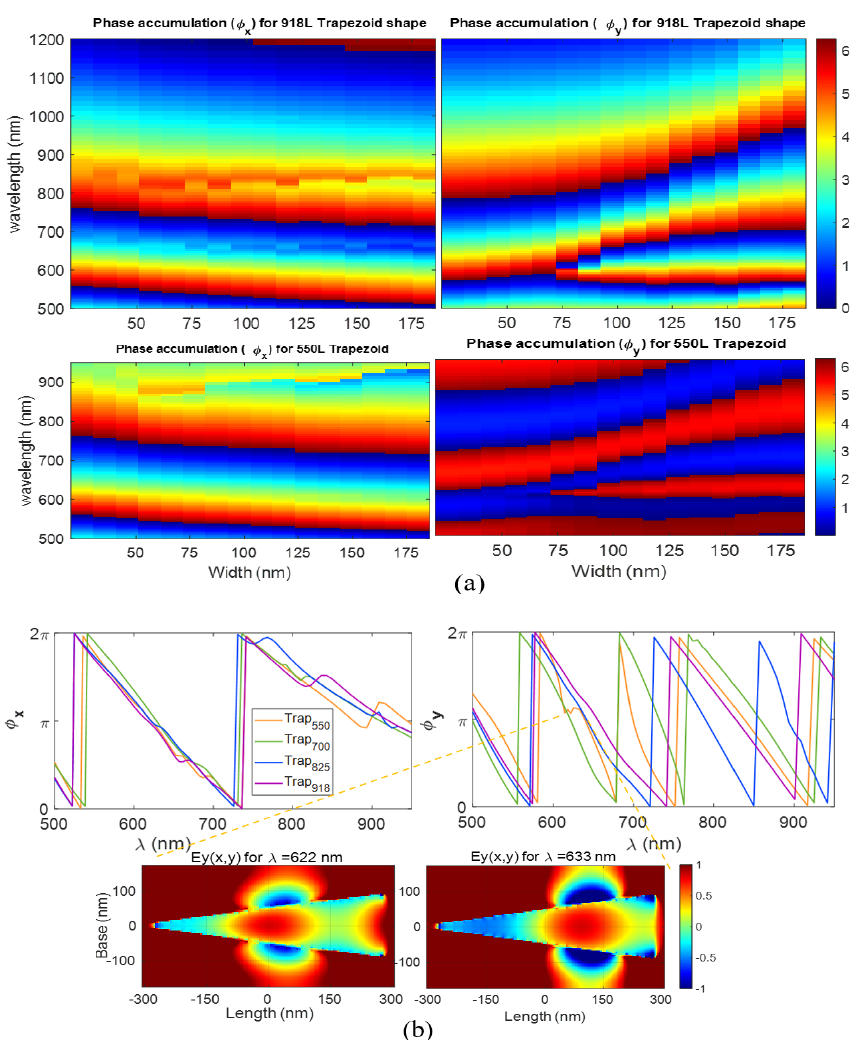
Figure 2. The phase gradient in effect from the trapezoid shape gradient: ( a ) the simulated 2D phase map for the Cu bar nanoantenna with increasing widths of the wavelength for 918L (top) and 550L (bottom); ( b ) the wavelength-dependent TM and TE phases for the four different Cu trapezoid lengths, in which the abrupt changes occurred due to shape-dependent resonance modes for the 550L trapezoid that did not affect the 918L trapezoid. The color bar scale values are in